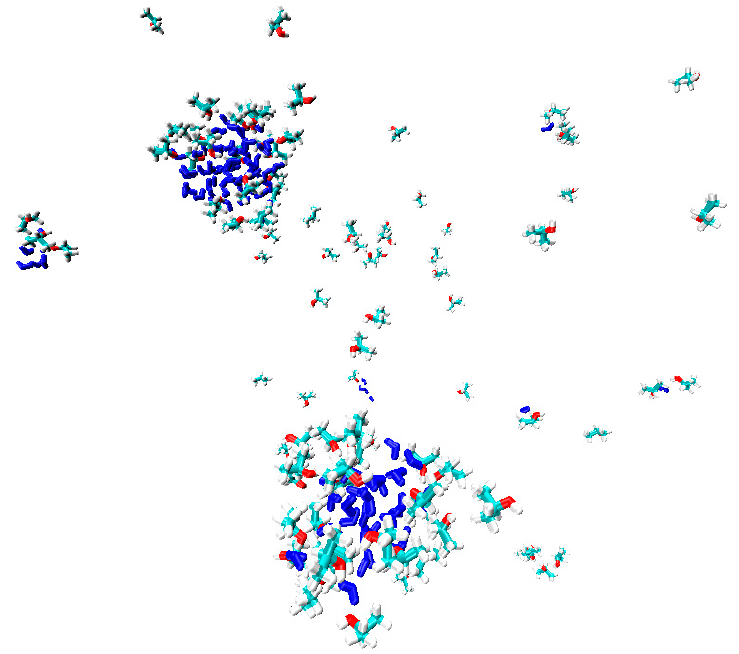
Figure 14. Snapshot of the PVDF/IPA+H 2 O system. PVDF atoms are hidden for clarity.